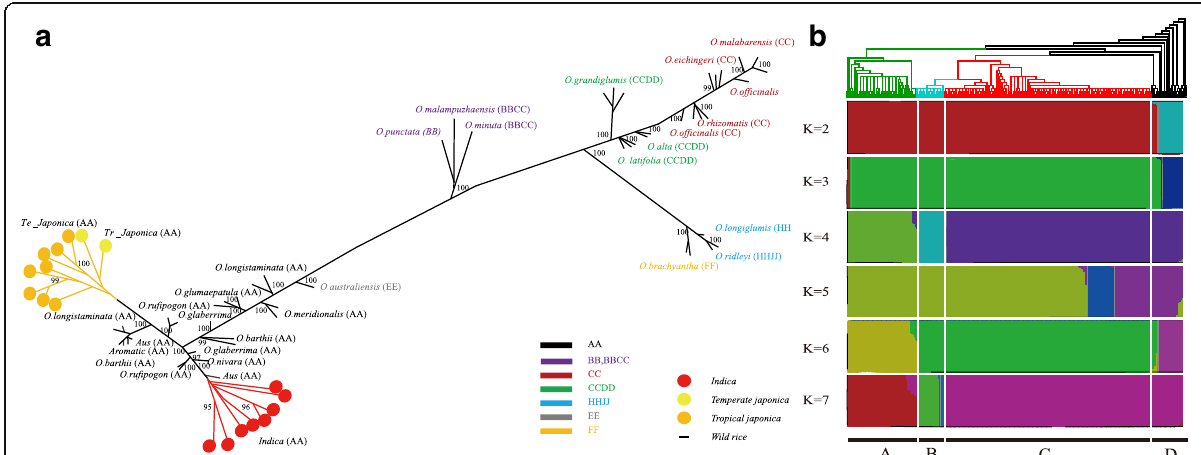
Fig. 3 Population structure and the phylogenetic tree of 412 rice accessions. ( a ) The Bayesian Inference tree estimated from MrBayes based on all high-quality SNPs. Here we briefly summarize the characteristics of the tree, the complete tree file we put in Additional file 11. Only the posterior probability bigger than 95 are represents in the figure. ( b ) The combined figure of phylogenetic tree and population structure. Here, the color of the tree is independent of the color of the structure. For population structure, it was conducted by fastStructure using K values from 2 to 7. a : indica type, b : tropical japonica type, c : temperate japonica type, d ; wild